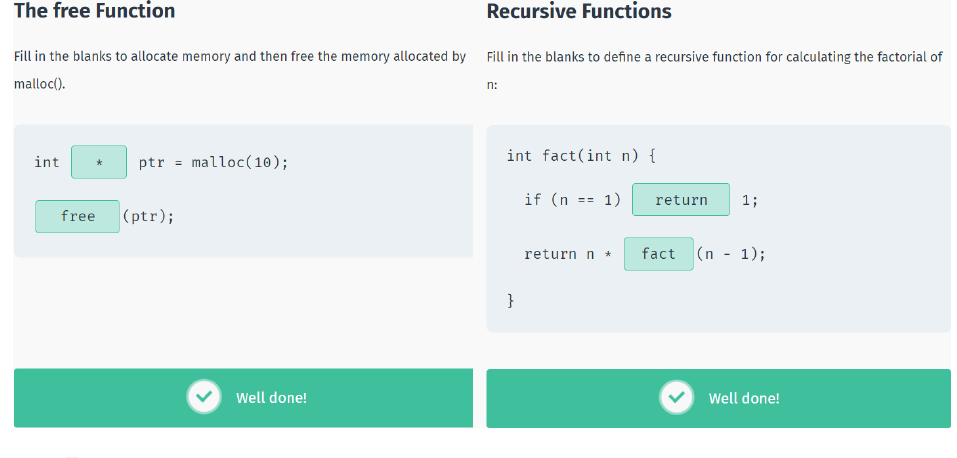
Figure 7: Entering your answer.